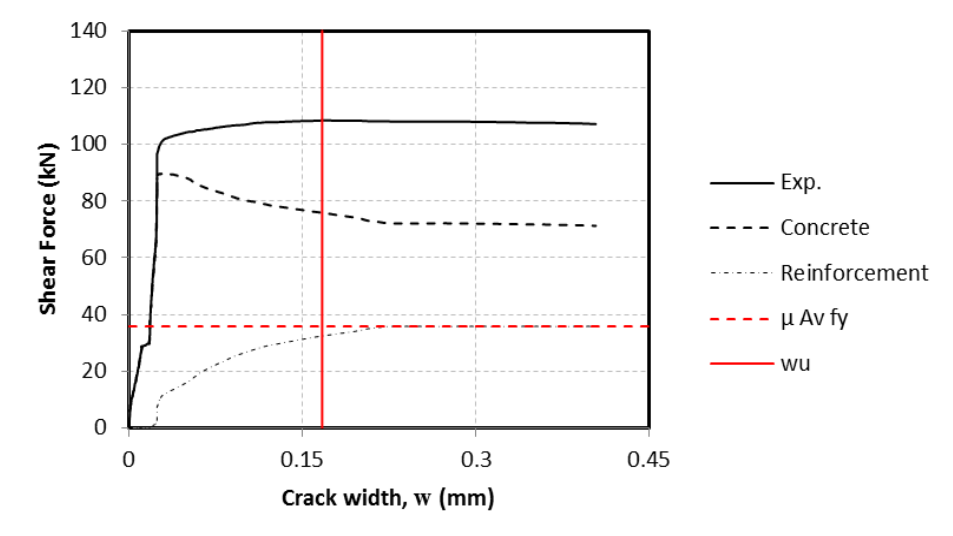
Figure 9. Experimental and theoretical shear strengths of CC-A